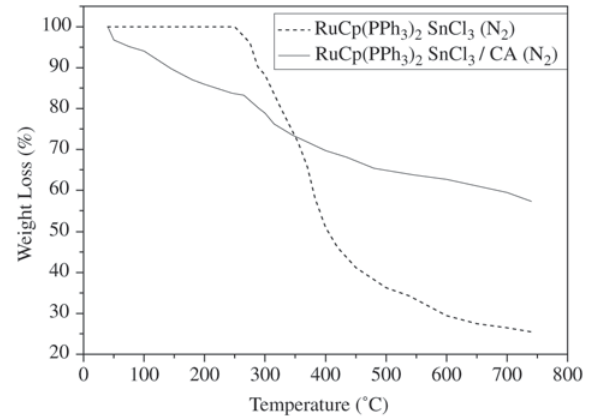
Figure 1. Thermogravimetric analyses of the precursor RuCp(PPh ) SnCl pure and supported on activated 3 2 3